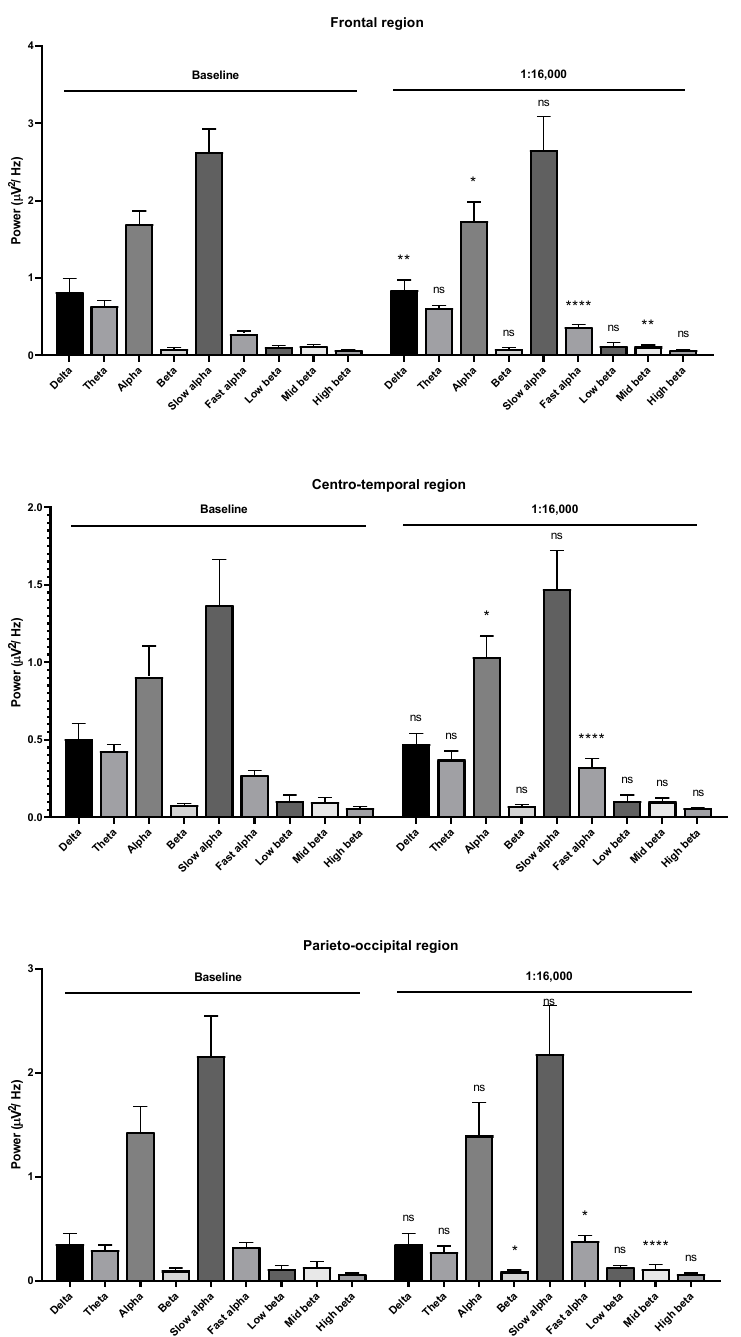
Figure 7. Effects of garlic oil inhalation at a 1:16,000 dilution on the delta, theta, alpha, beta, slow alpha, fast alpha, low beta, mid beta, and high beta wave powers: ( upper ) frontal region; ( middle ) centro-temporal region; ( lower ) parieto-occipital region. p value: not significant (ns) ≥ 0.05, * < 0.05, ** < 0.01, and **** < 0.0001.